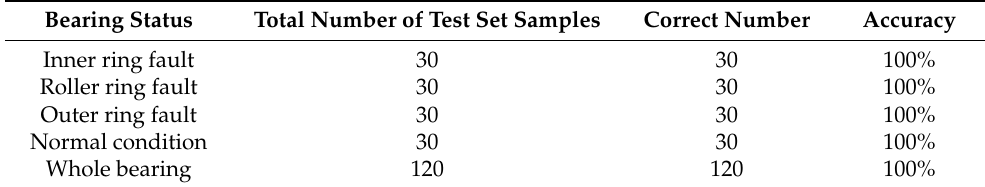
Table 3. PSO-DBN model accuracy with VMD-CMDE as input .